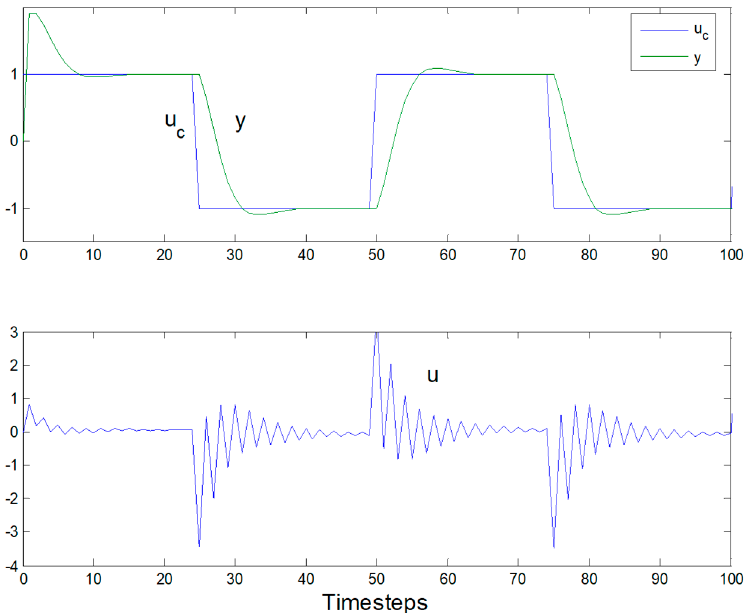
Figure 9 . Control u ( t ) output y ( t ) versus time for Direct Self-Tuner with pole excess d 0 = 1: Note the control “chattering”.